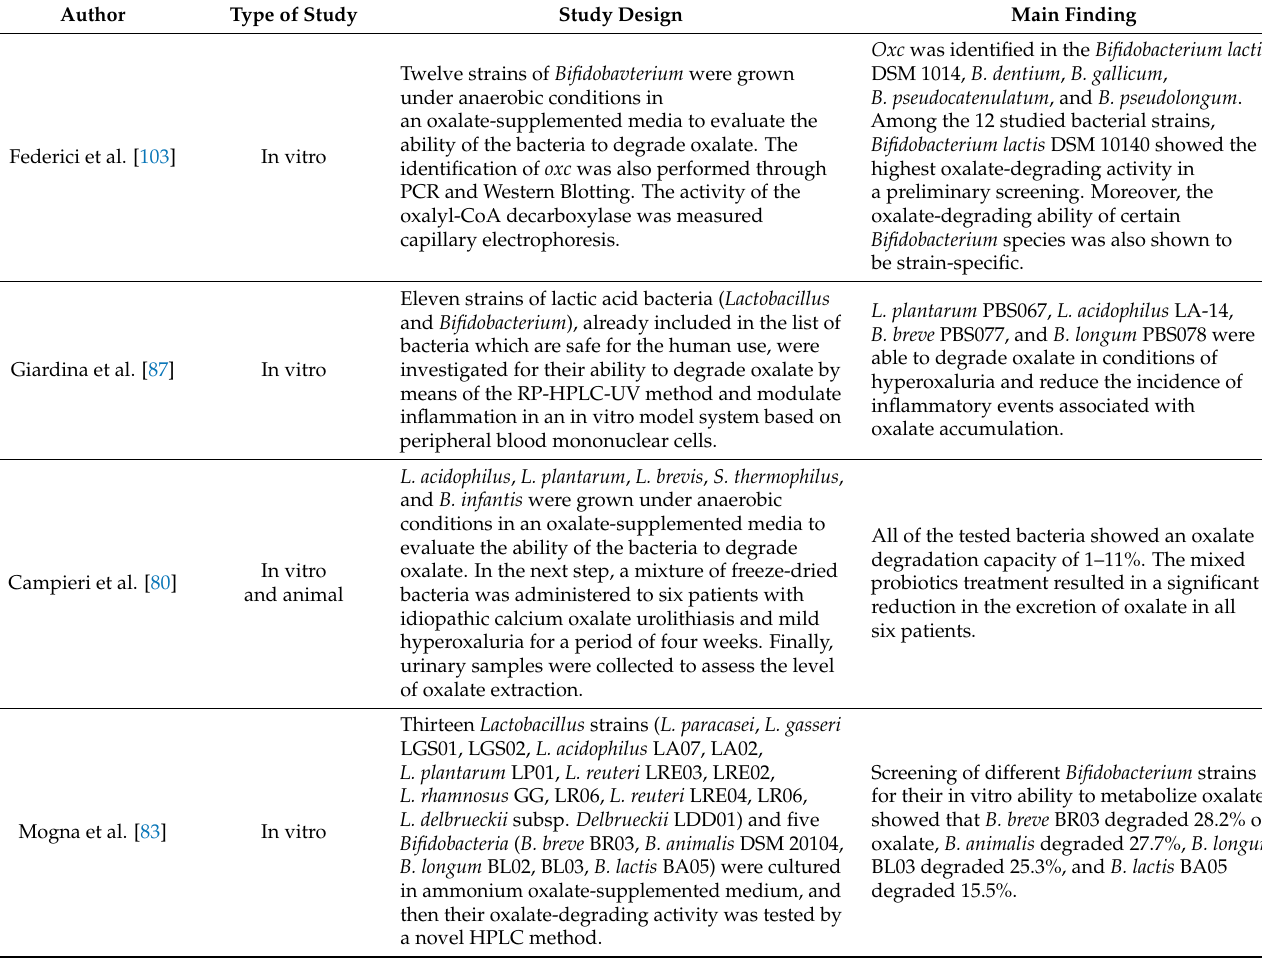
Table 7. A summary of previous studies on the use of Bifdobacterum spp. for the prevention of